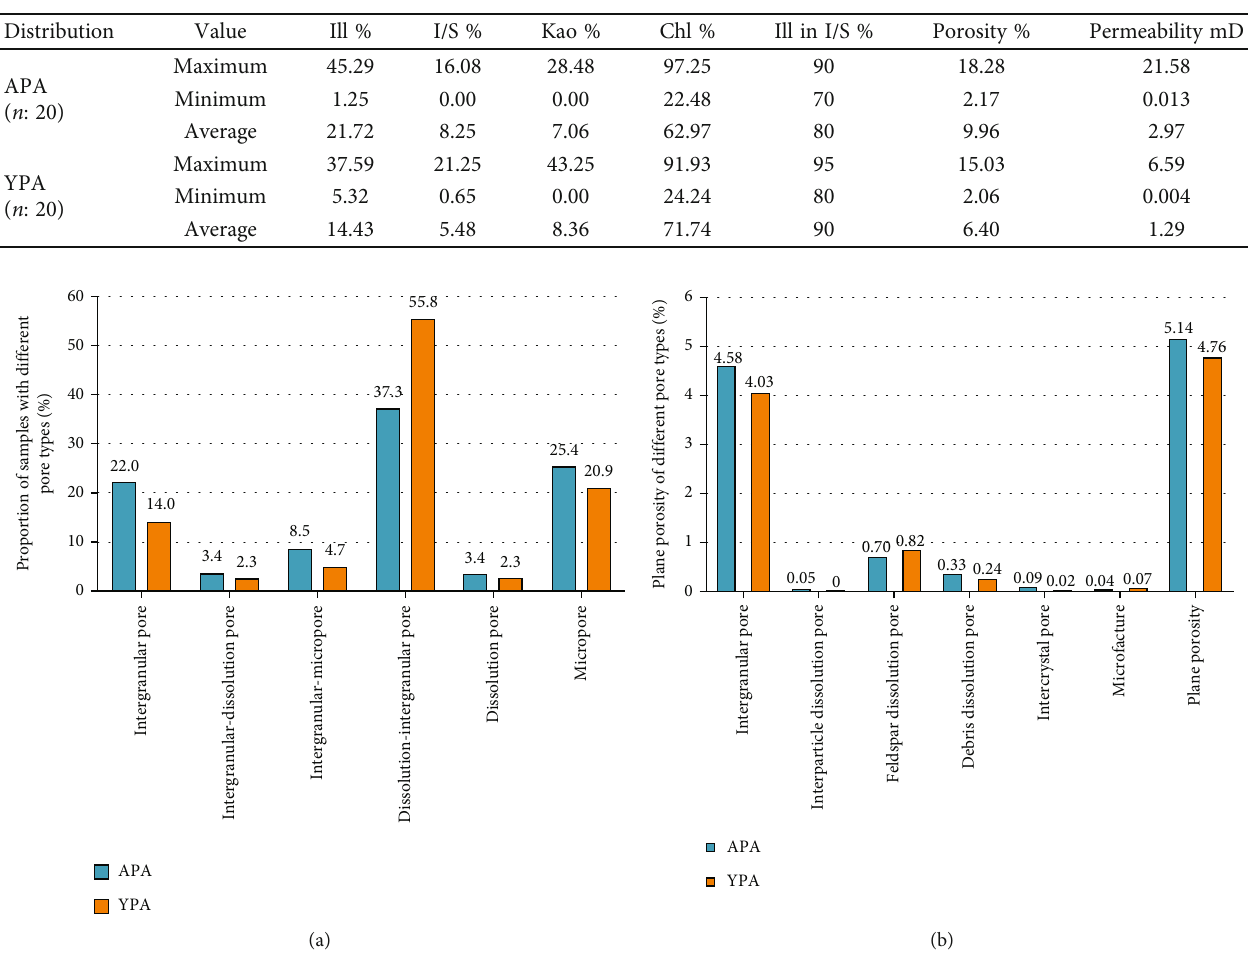
Figure 5: Comparison of reservoir space types and characteristics between the YPA and APA. (a) Proportion of samples with di ff erent pore types in the YPA and APA reservoirs. (b) Plane porosity di ff erences of six pore types in the YPA and